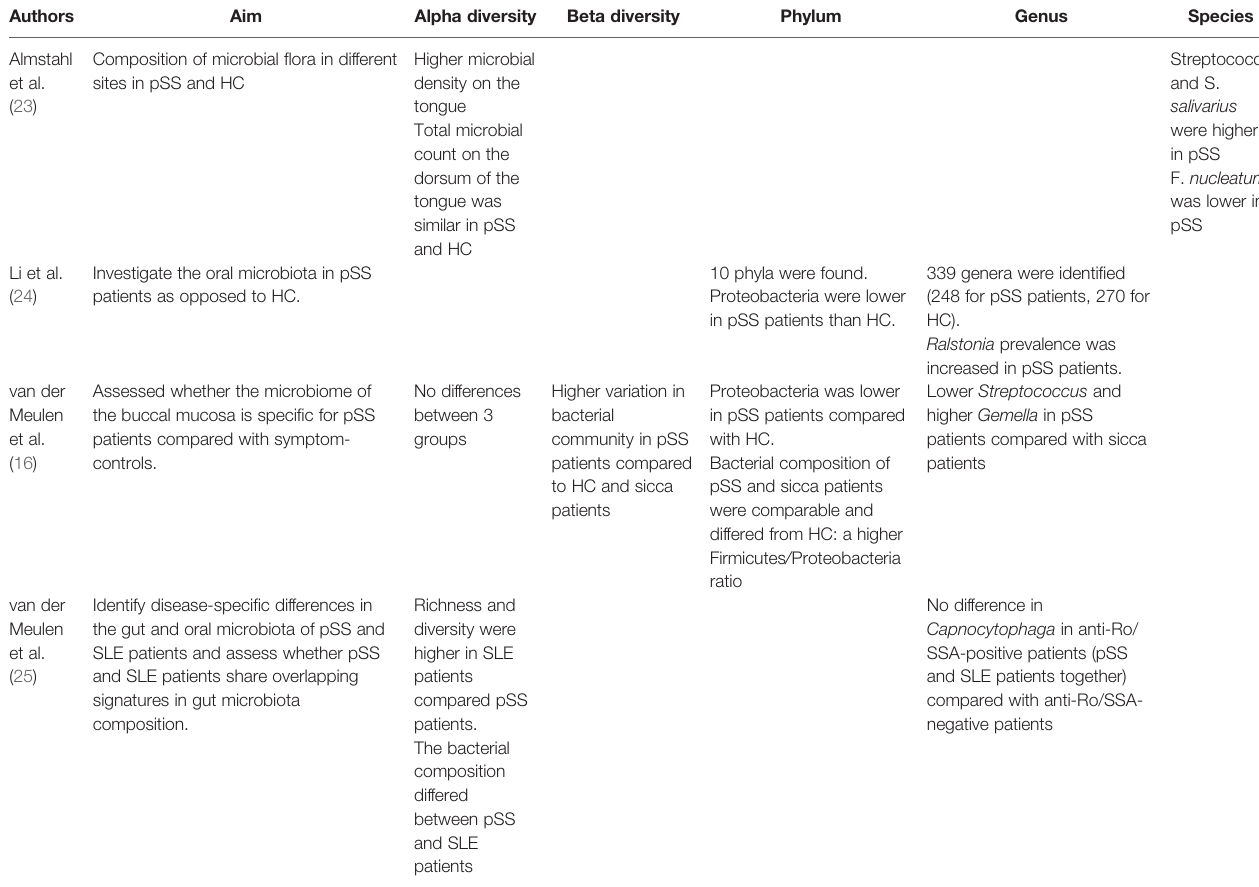
TABLE 4 | Analysis of the results of the included studies relying on buccal swabs in pSS patients compared to HCs and sicca